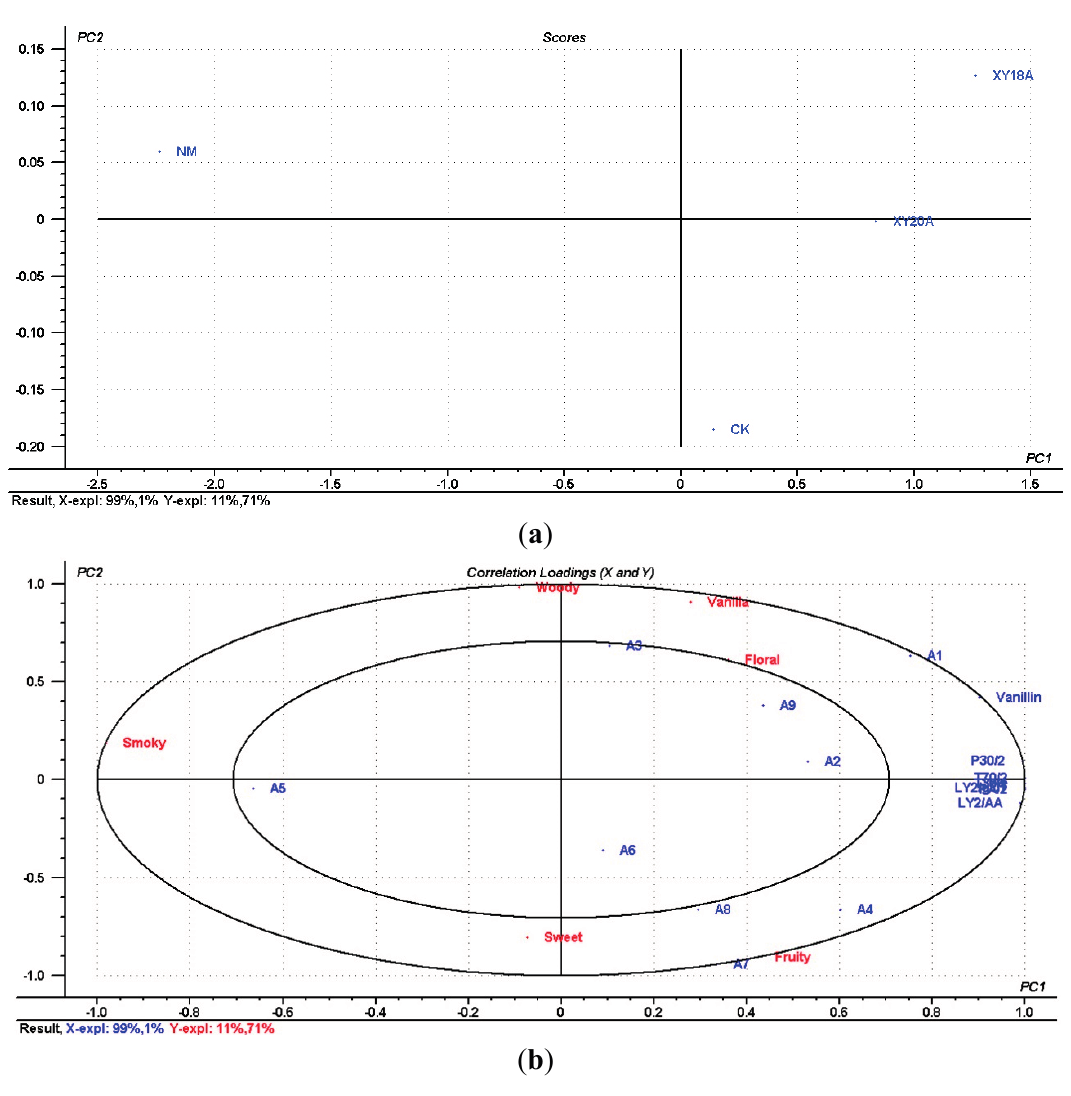
Figure 4. Correlation of the characteristic compounds, E-nose response, and sensory attributes of VFs. ( a ) PLSR correlation loading plot of selected odor-active compounds, E-nose response, and sensory attributes for four VFs. Selected compounds A1–A9 correspond to the coded compounds in Table 2. ( b ) Plot of the first two principal components based onselected odor-active compounds, E-nose response, and sensory attributes for four